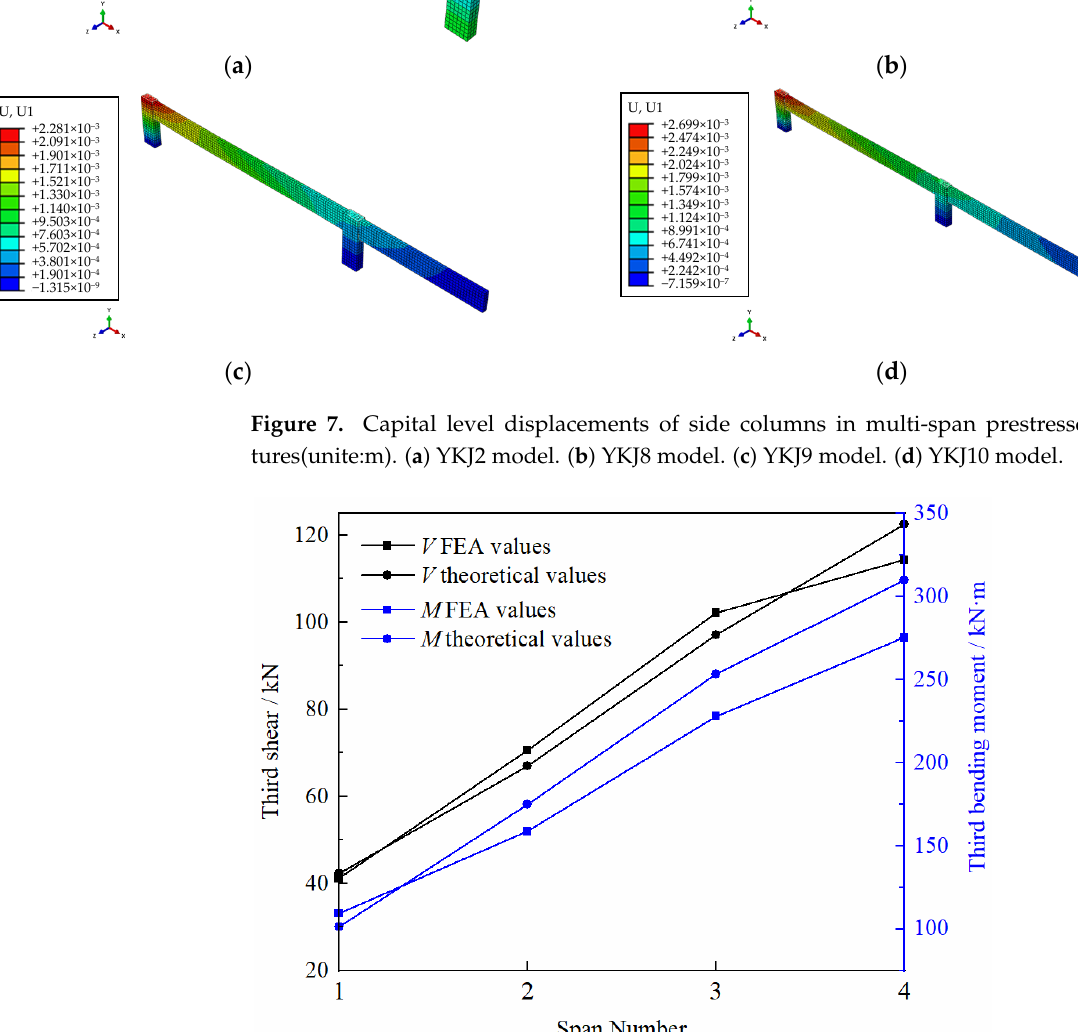
Figure 8. Relationship between span number and third shear and third bending moment.